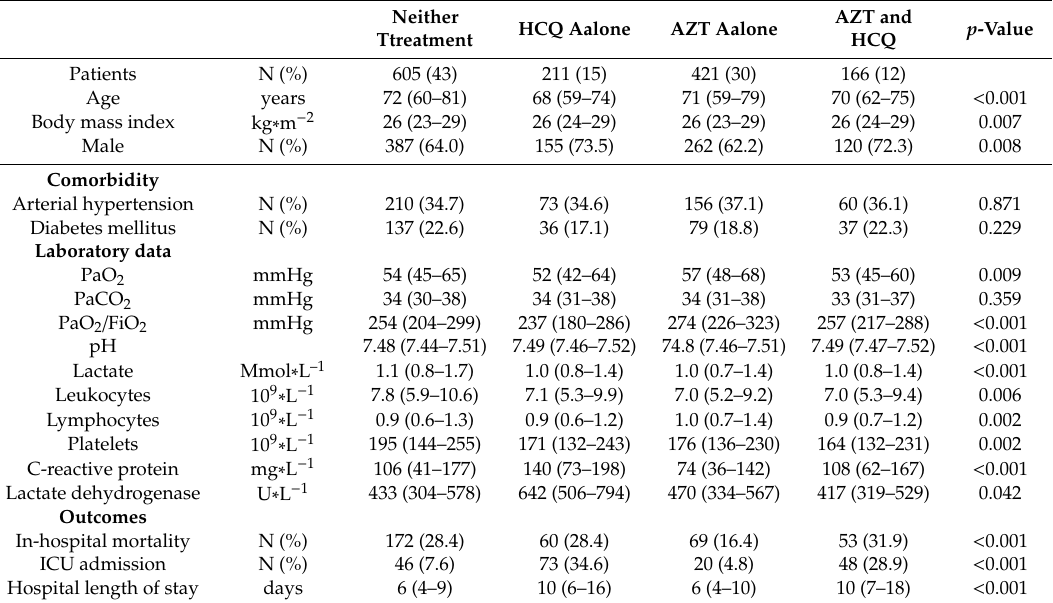
Table 1. Patients’ characteristics and outcome in the four groups.